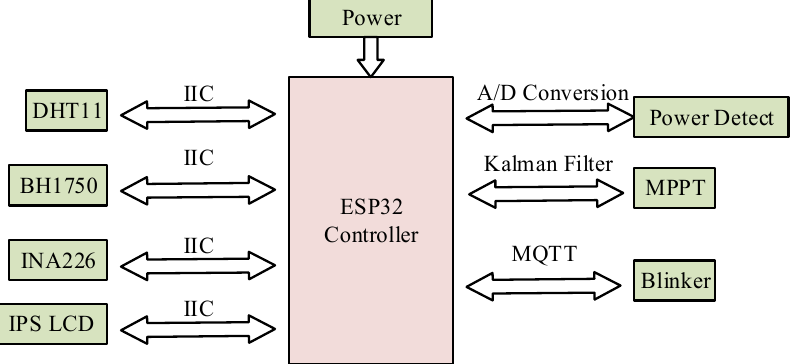
Figure 17. Communication relations of each module.